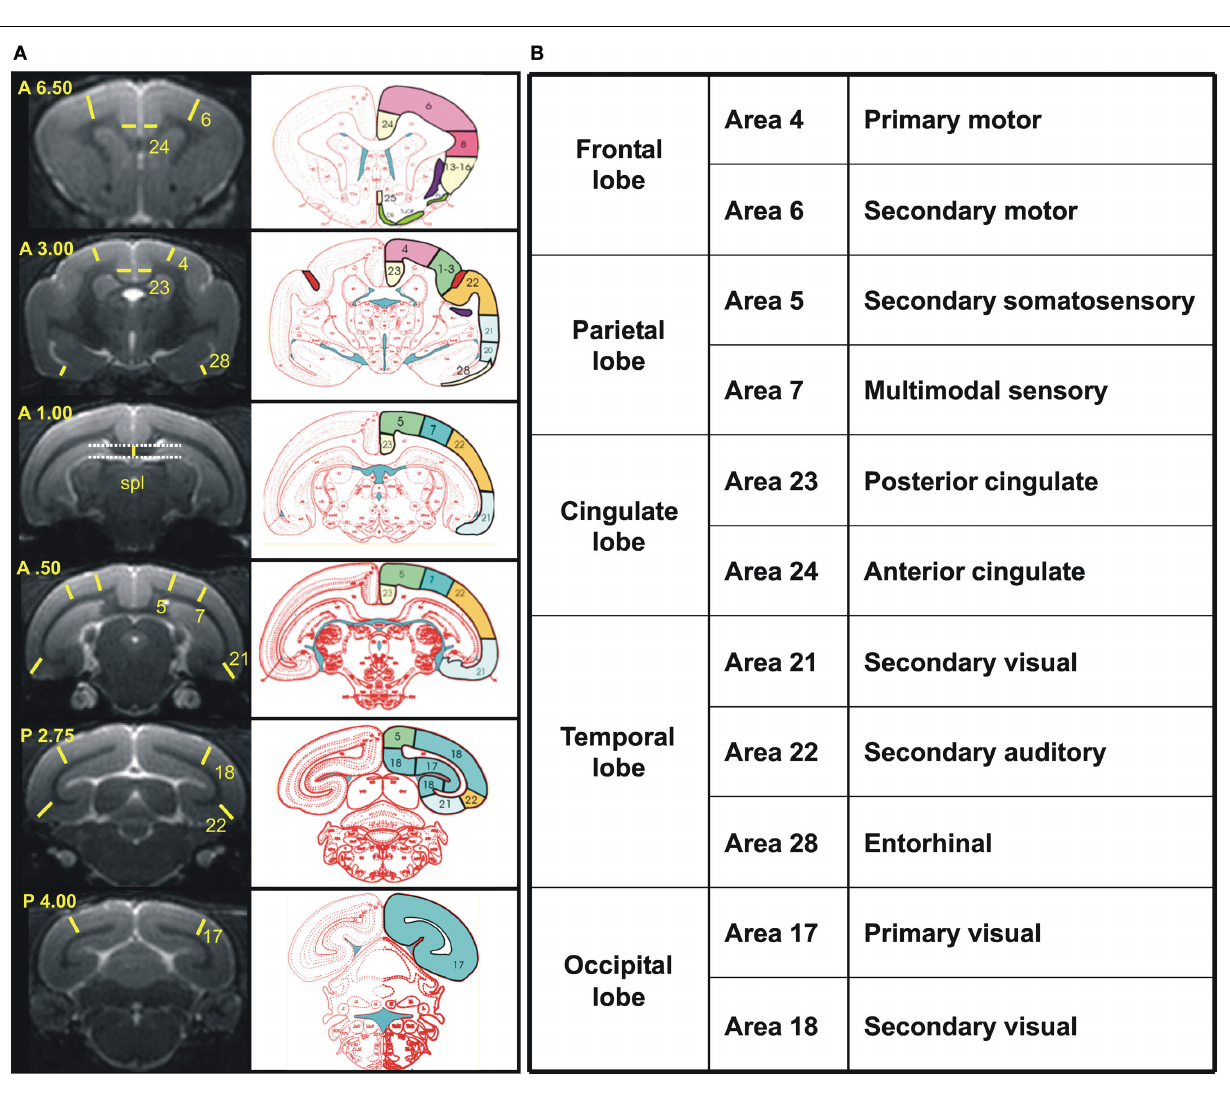
(1998) are noted in the superior left corner of each slice. Right, schematic sections from the atlas of Bons et al. corresponding to the coronal slices on the left column with identification of the Brodmann’s cortical areas measured (http://marc.dhenain.free.fr/Mouse-Lemur-Atlas/index-Mouse-Lemur-Atlas.html). Spl, splenium. (B ) An overview of the cortical regions is shown in the